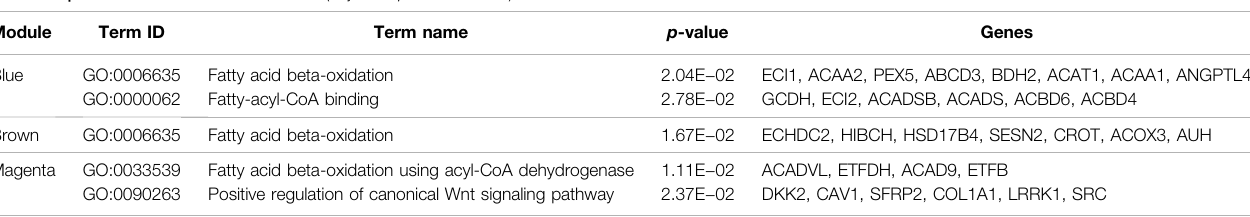
TABLE 2 | GO terms of candidate modules (adjusted p -value ≤ 0.05).